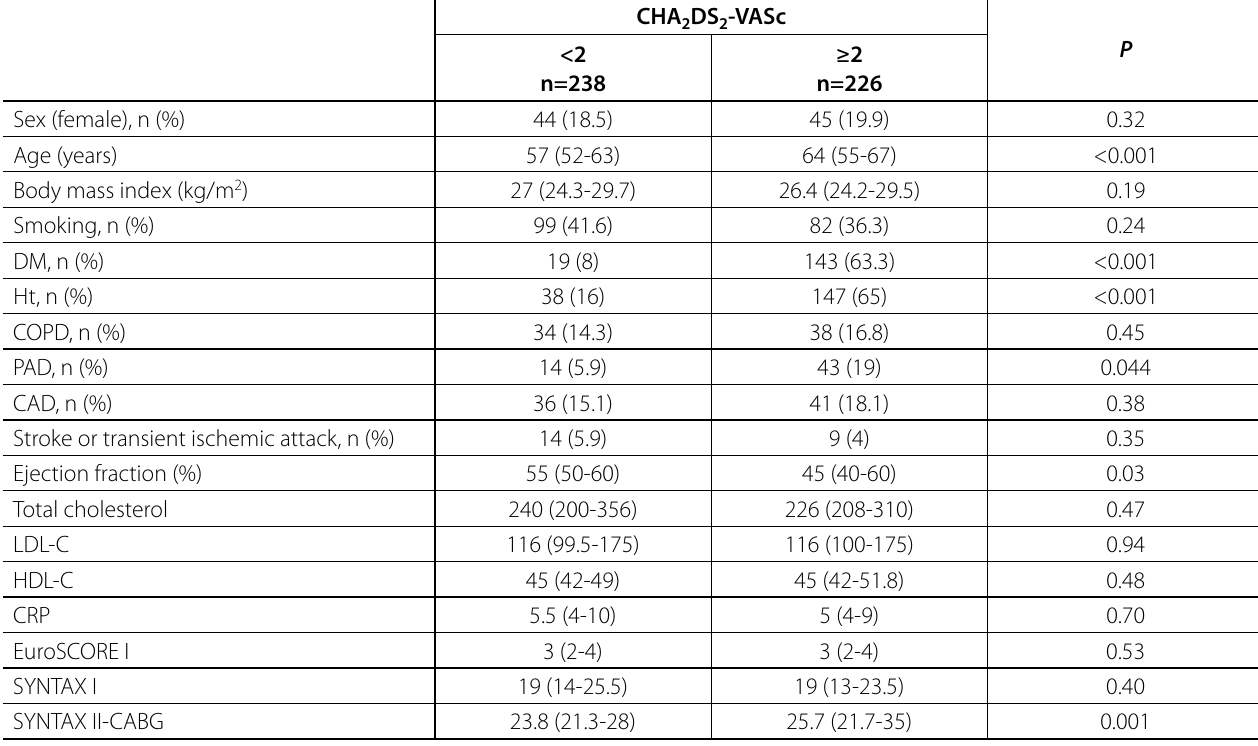
Table 1 . Demographic, clinical, and laboratory characteristics of the